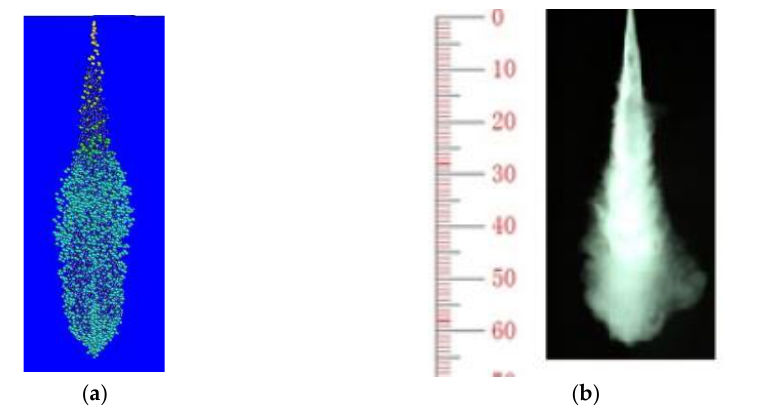
Figure 8. Comparison of the liquid penetration lengths between the simulated and experimental